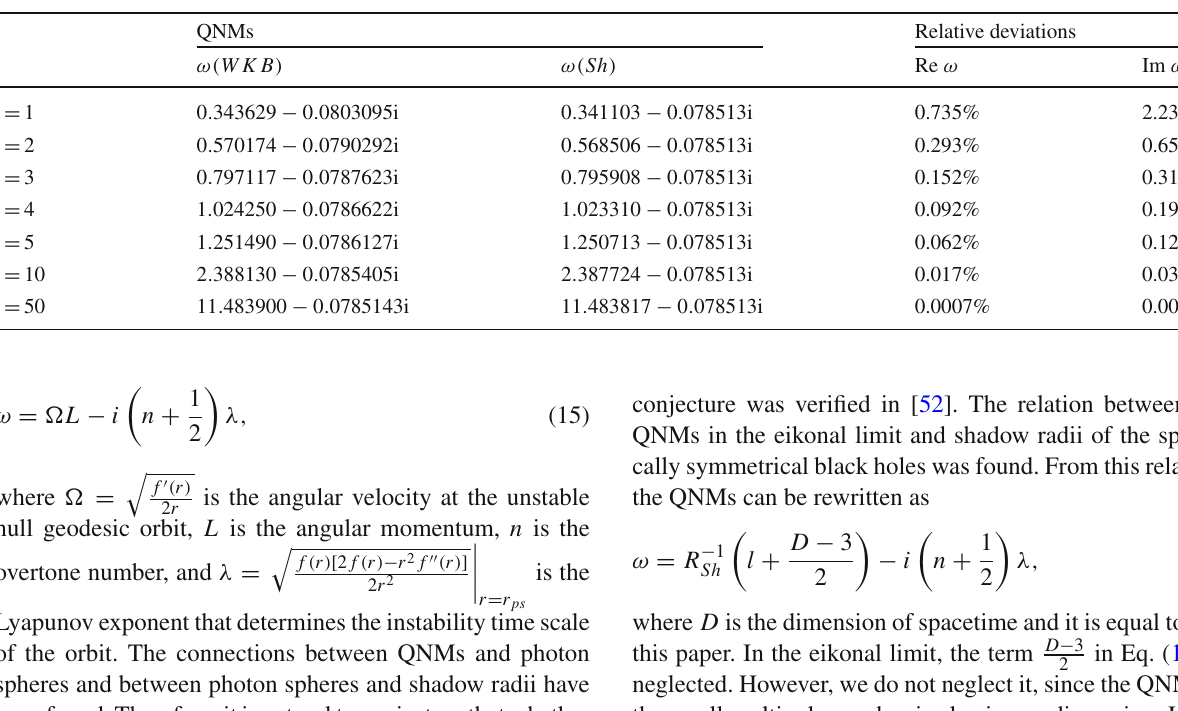
Table 10 The QNMs derived by the WKB approximation approach and shadow radius and the relative deviations. In the calculation, we let Q = 0 . 7 and α = 0 .